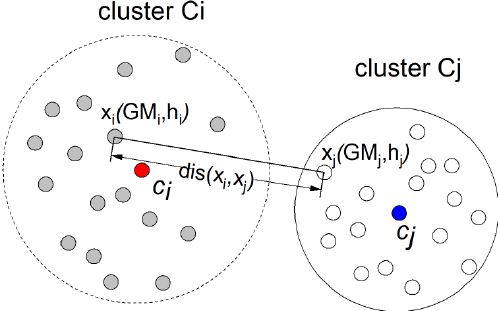
Table 1. Key parameters of the BIT-lidar.